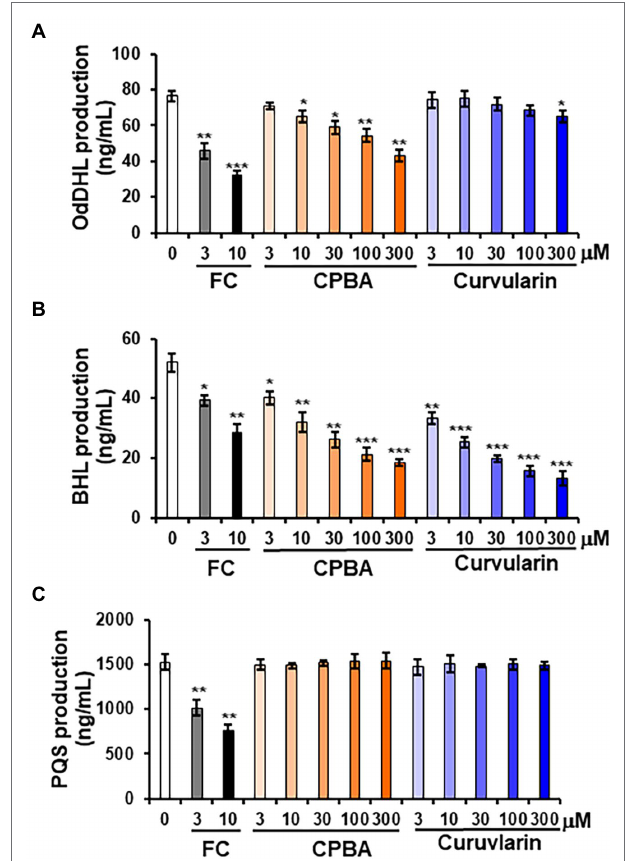
FIGURE 4 | Effects of curvularin on QS signaling molecule production. PA14 cells were cultured in LB medium in the presence of curvularin for 12 h. The three main QS molecules, namely, OdDHL (A) , BHL (B) , and PQS (C) , were extracted from the culture supernatants and quantitatively analyzed by LC–MS/MS. FC and CPBA are known antagonists of LasR and RhlR, respectively. Three independent experiments were performed in triplicate, and the mean ± SD values are presented in each bar. * p < 0.01; ** p < 0.001; and *** p < 0.0001 versus DMSO